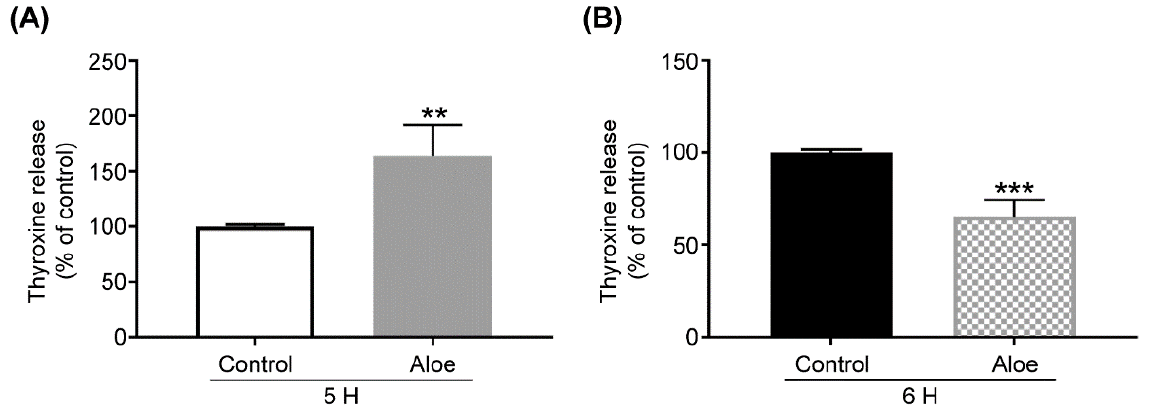
Figure 1. Effects of Aloe (AV) on the regulation of thyroxine release in FRTL-5 cells. Cells were treated with 10 µ g/mL AV in 5H ( A ) and 6H ( B ) media conditions, and thyroxine levels released into culture media were measured. Data were represented as means ± SD ( n = 3); ** p < 0.01, *** p < 0.001 versus control.